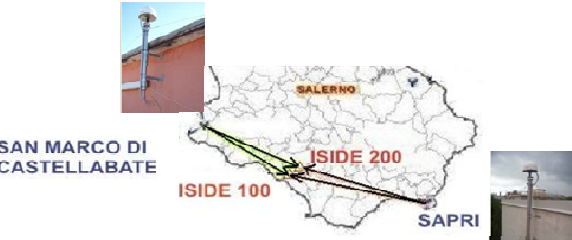
Figure 1. RTK Permanent GNSS Stations (